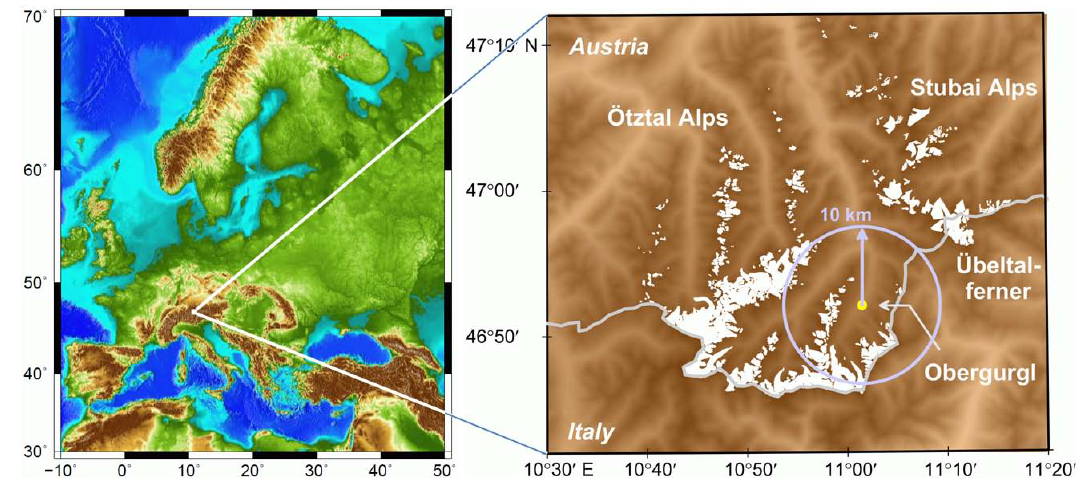
Fig. 1. Location of the absolute gravity station Obergurgl and surrounding glaciers considered in this paper. The map of the left panel is based on the ETOPO2v2 Global Gridded 2min Database, National Geophysical Data Center, National Oceanic and Atmospheric Administration, US Dept. of Commerce, http://www.ngdc.noaa.gov/mgg/global/etopo2.html, and was drawn using the software by Wessel and Smith (1991). Right panel: Glacier areas in 1997 (white). The grey line shows the border between Austria and Italy. The yellow dot marks the gravity station at